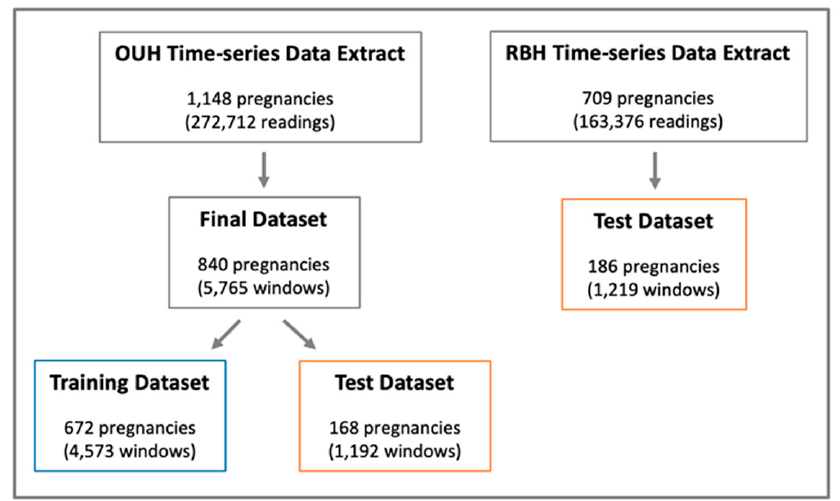
Figure 2. Final datasets after all data exclusion considerations, pre-processing methods, and train- ing/testing split (80:20) of the OUH dataset.